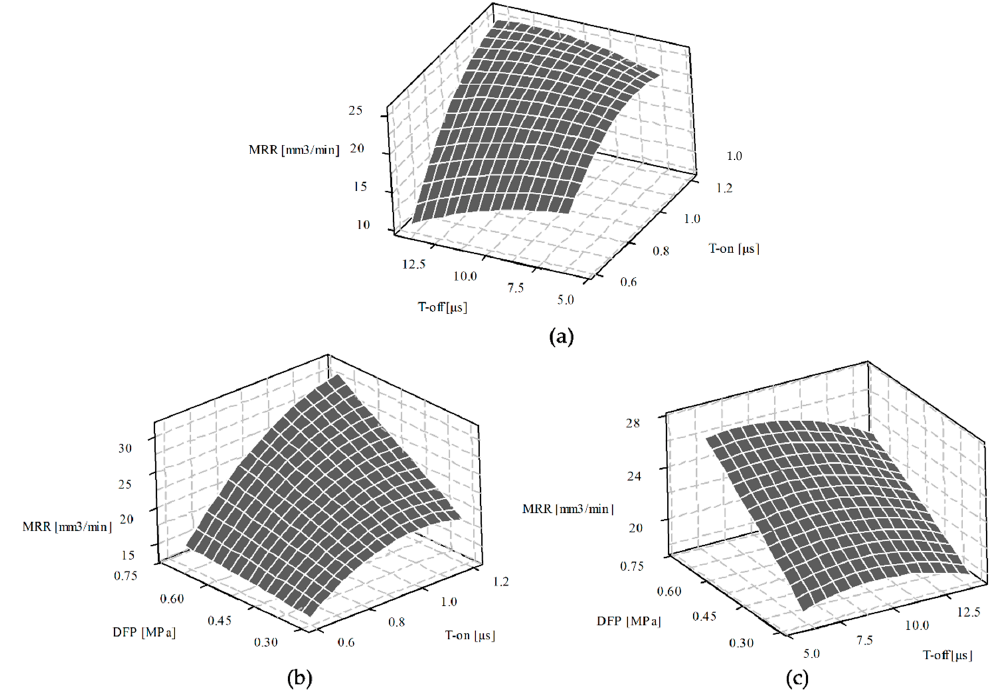
Figure 3. Response surface 3D plots representing the MRR dependence on: ( a ) T-on and T-off, for DFP = 0.5 MPa; ( b ) T-on and DFP, for T-off = 10 µs; ( c ) T-off and DFP, for T-on = 0.9 µs.